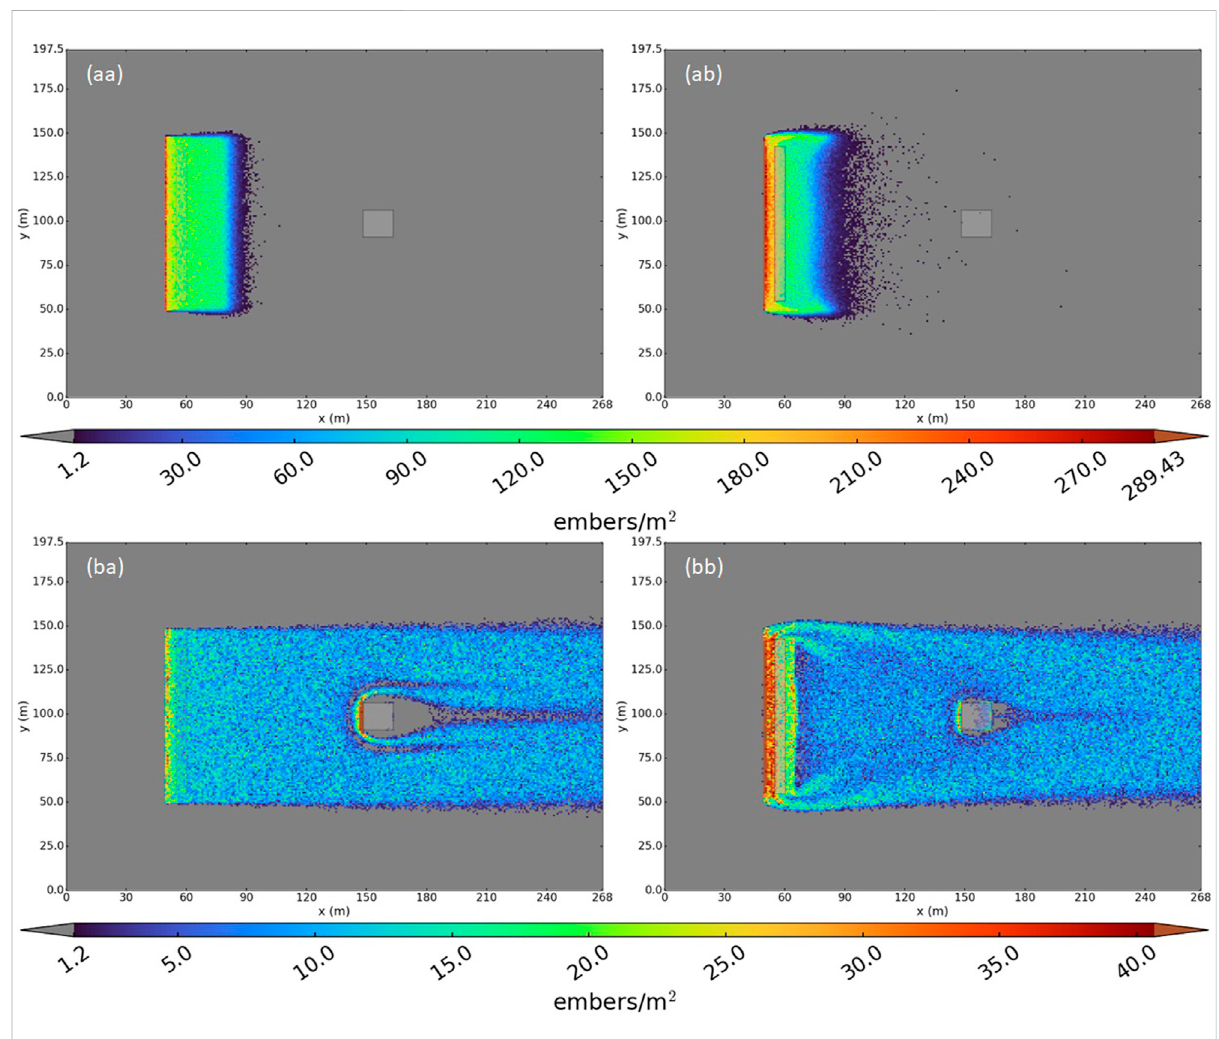
FIGURE 13 Firebrand deposition for the 2.2 m/s and 27 m/s wind speed cases. (aa) 2.2 m/s without the fence. (ab) 2.2 m/s with the fence. (ba) 27 m/s without the fence. (bb) 27 m/s with the fence. Colors: deposition per unit